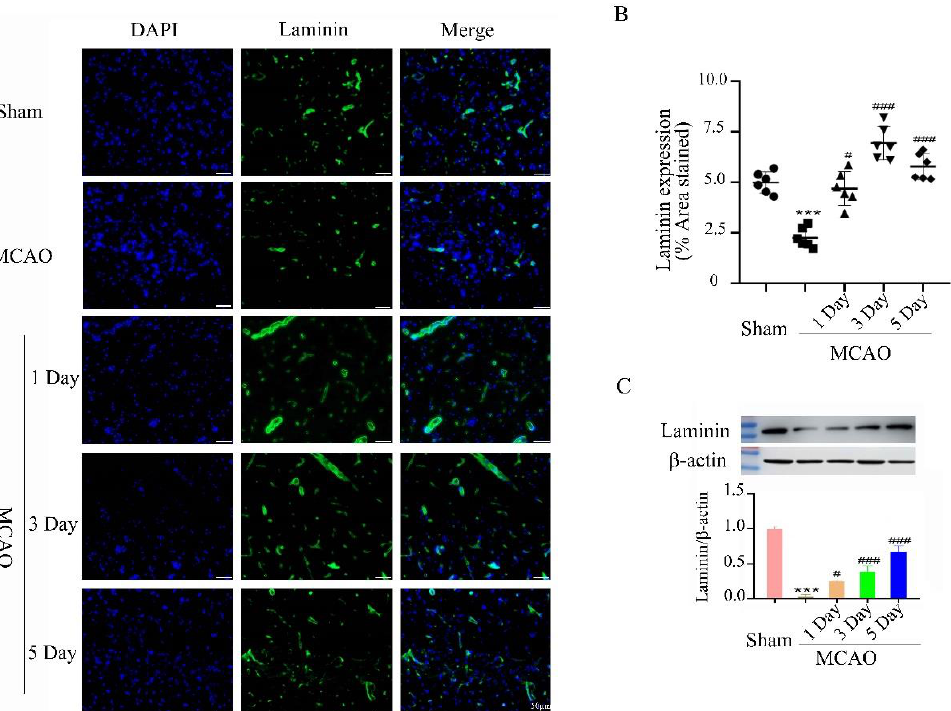
Figure 4. The effect of 24 h treadmill exercise after MCAO on the expression of laminin and microvessel density. ( A ) The laminin expression was detected by immunofluorescence method in the brain of the rats in the Sham, MCAO, 1 day, 3 days, and 5 days in treadmill exercise 24 h after MCAO groups; bars: 50 µ m; ( B ) Quantification of microvessel density as shown by laminin expression (% area stained) in the brain of the rats in the Sham, MCAO, 1 day, 3 days, and 5 days in treadmill exercise 24 h after MCAO group; ( C ) The laminin expression was detected by Western blot method in the brain of the rats in the Sham, MCAO, 1 day, 3 days and 5 days in treadmill exercise 24 h after MCAO groups. (*** p < 0.001 vs. Sham; # p < 0.01, ### p < 0.001 vs. MCAO, n =